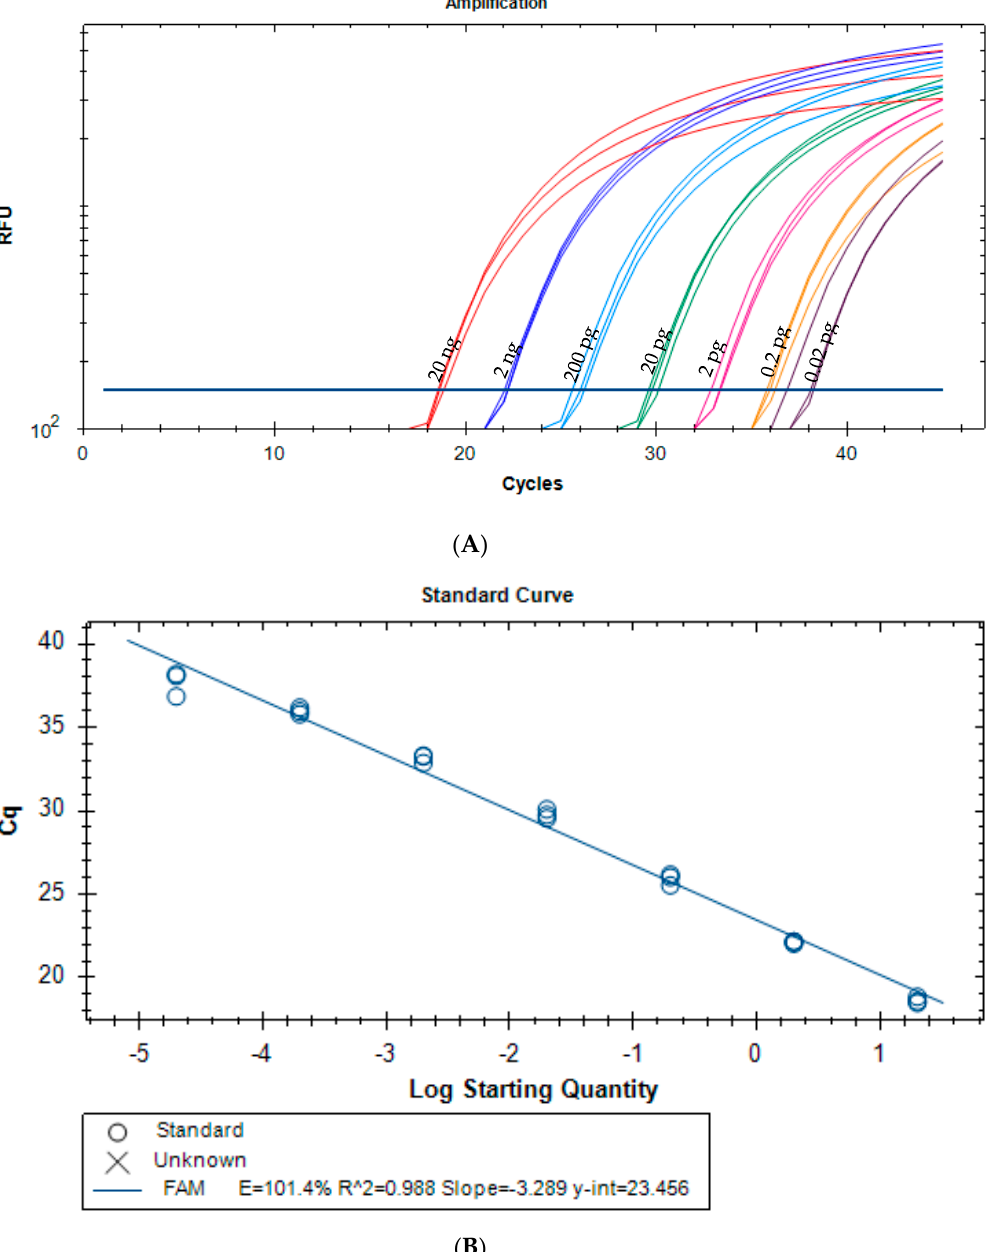
Figure 1. Amplification curves ( A ) and respective calibration curve ( B ) of a real-time PCR assay with a hydrolysis probe targeting ITS1 region of G. biloba . The amplified extracts correspond to 10-fold serially diluted ginkgo DNA from 20 ng to 0.002 pg ( n = 3 replicates). Cq (cycle of quantification, also known as Ct, cycle threshold).